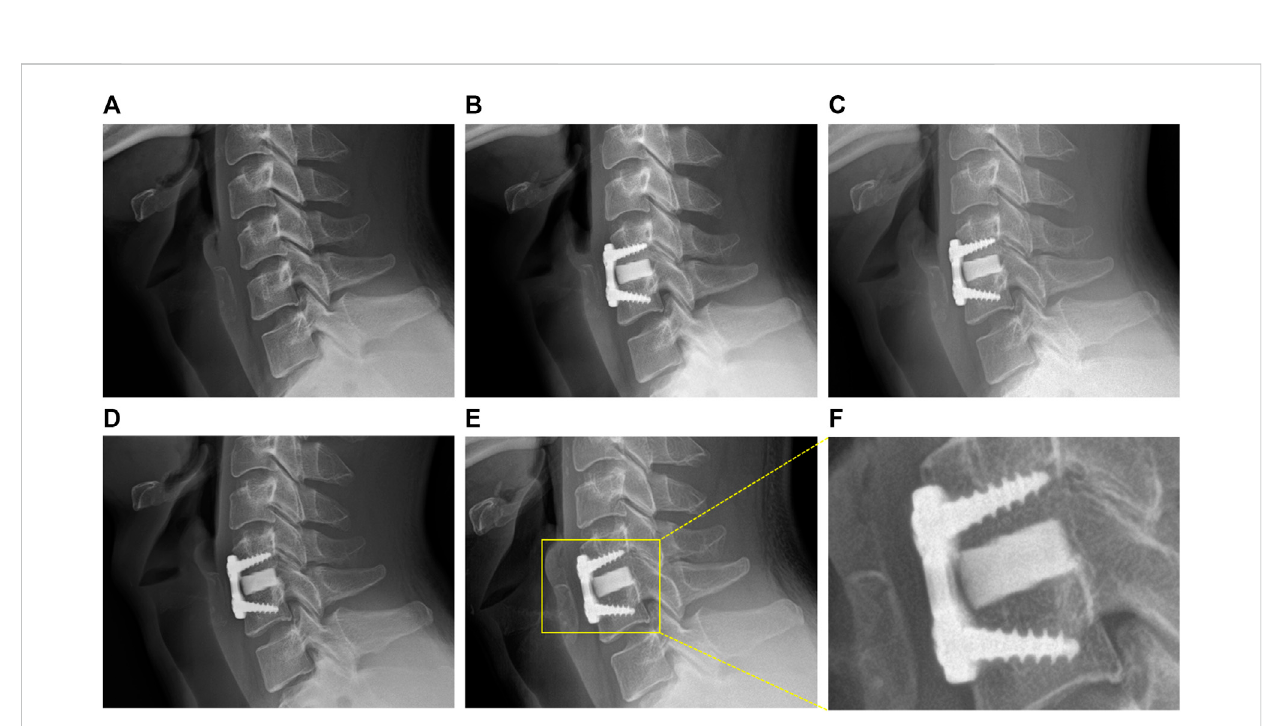
FIGURE 3 Representative images of BGS-7 spacer-induced segmental fusion progression after ACDF surgery during 5 years. (A) Pre-OP, (B) 1 month, (C) 3 months, (D) 1 year, (E) present, (F) present - magni fi